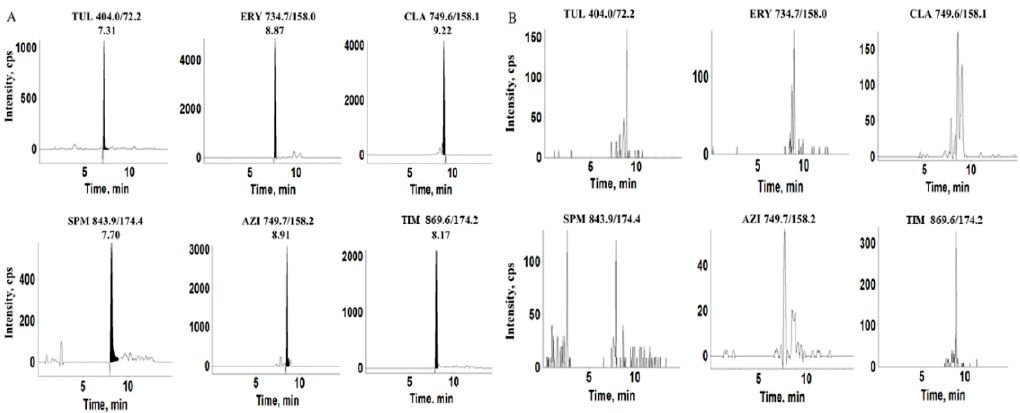
Figure 6. Typical SRM chromatograms obtained from ( A ) spiked chicken matrix at the concentration of 5 μ g/kg and ( B ) blank chicken matrix.